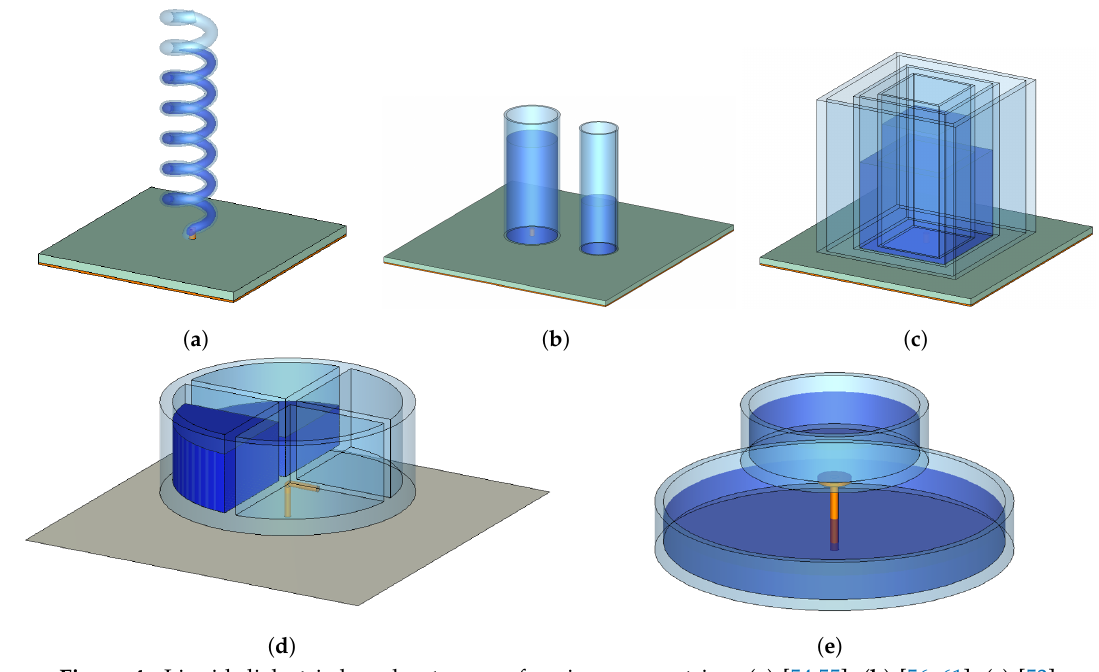
Figure 4. Liquid dielectric based antennas of various geometries. ( a ) [54,55], ( b ) [56–61], ( c ) [53], ( d ) [62], ( e )